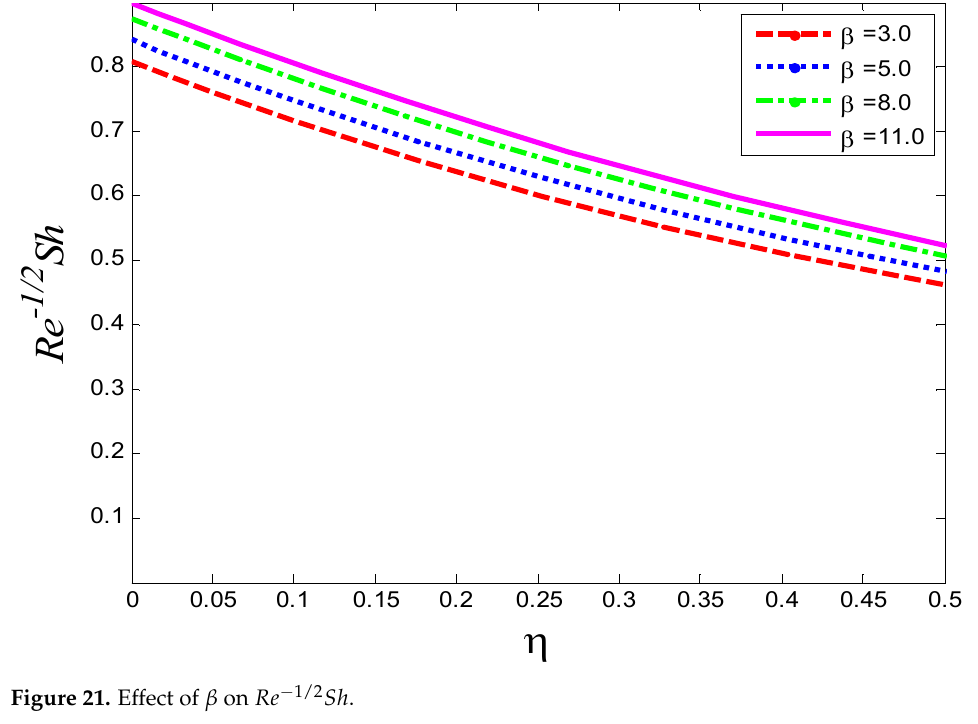
Figure 21. Effect of β on Re − 1/2 Sh .